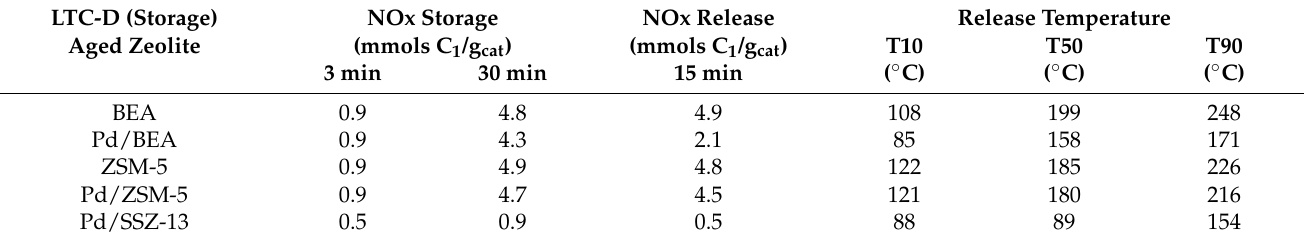
Figure 6. Following hydrothermal aging at 800 °C for 50 h ( a ) THC adsorption after 3 ( ) and 30 ( ) minutes for each of the materials studied, and ( b ) the temperature where 10% (T10, ■ ), 50% (T50, ■ ), or 90% (T90, ■ ) of THC is released. Table 3. THC storage values (mmol/g cat ) for hydrothermally aged samples; THCs are reported on a C 1 basis. The temperature where 10% (T10), 50% (T50), or 90% (T90) of THC is released is also shown.